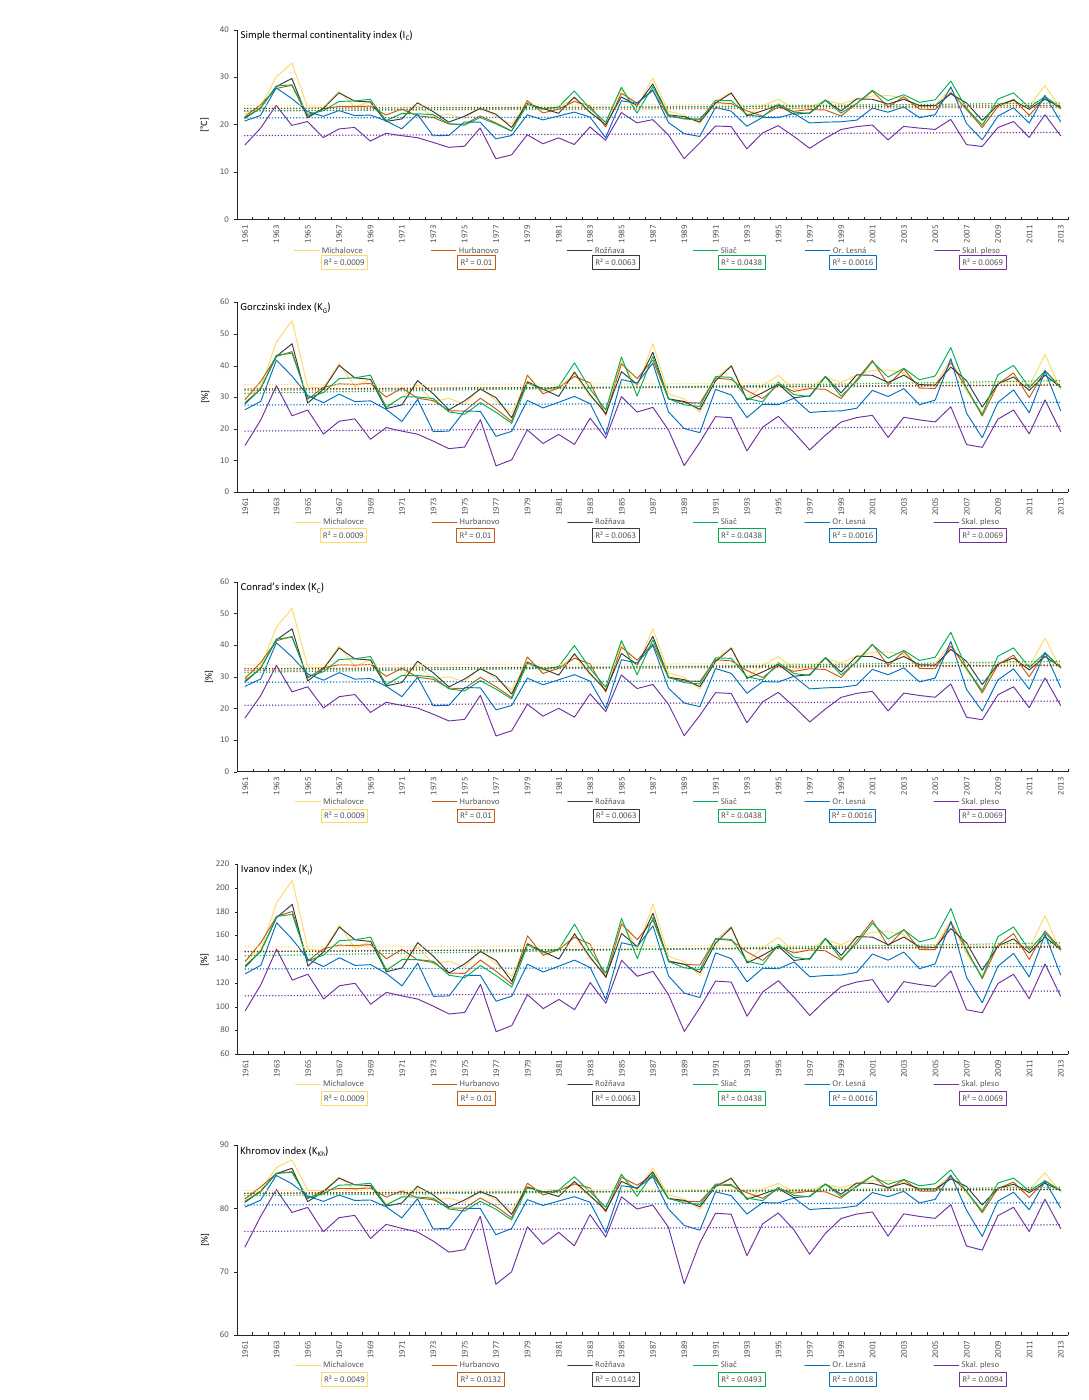
Figure 4. Linear trends of the thermal continentality indices within the period 1961 to 2013.